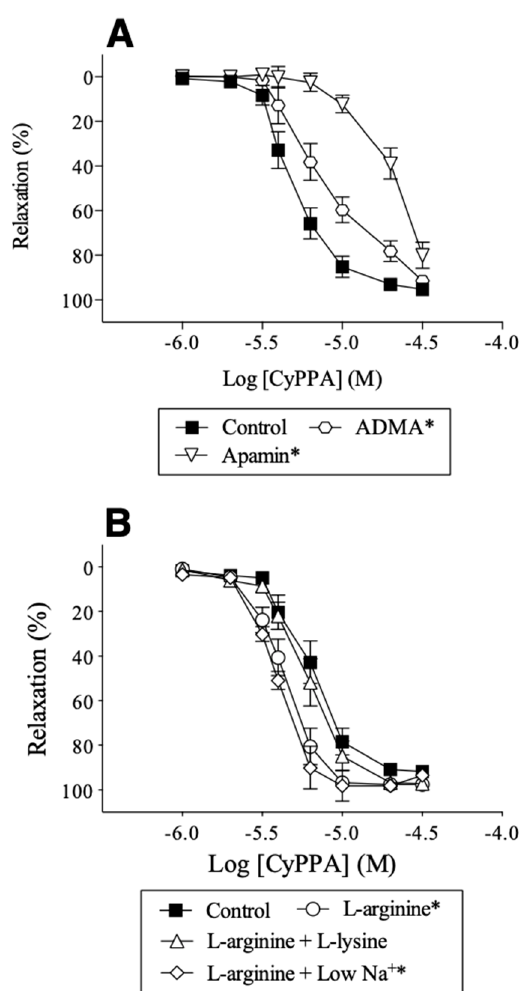
Figure 5. Modulation of CyPPA-induced relaxation in porcine retinal arterioles by ( A ) ADMA (300 µ M), an inhibitor of NO synthase, apamin (0.5 µ M), a blocker of SKCa channels, by ( B ) l -arginine (100 µ M), l -lysine (600 µ M), and low Na + -PSS. Data are means ± S.E.M. ( n = 7–9). Two-way ANOVA. * p < 0.05 vs . control.